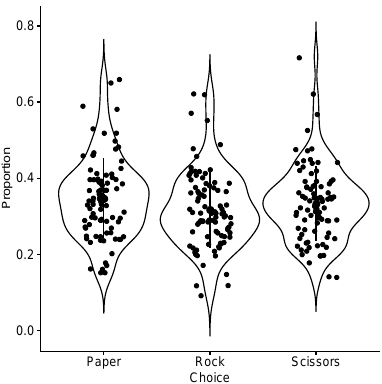
Figure 2. The proportion of choices selected by each player. The dot in the center represents the mean with the line represents one ± standard